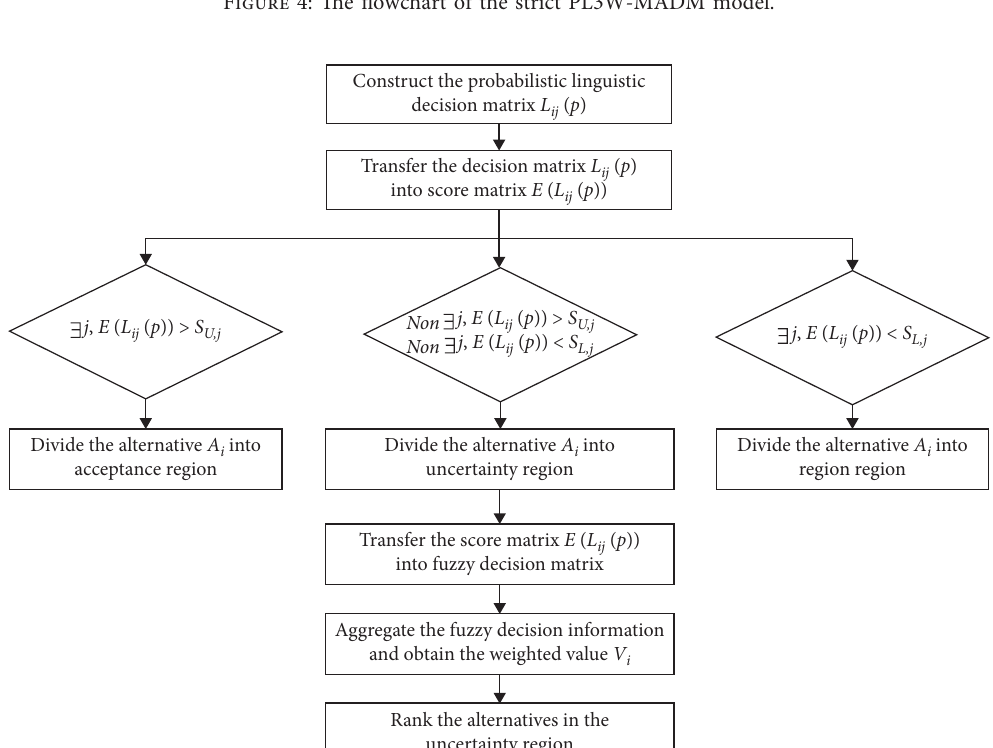
Figure 4: The flowchart of the strict PL3W-MADM